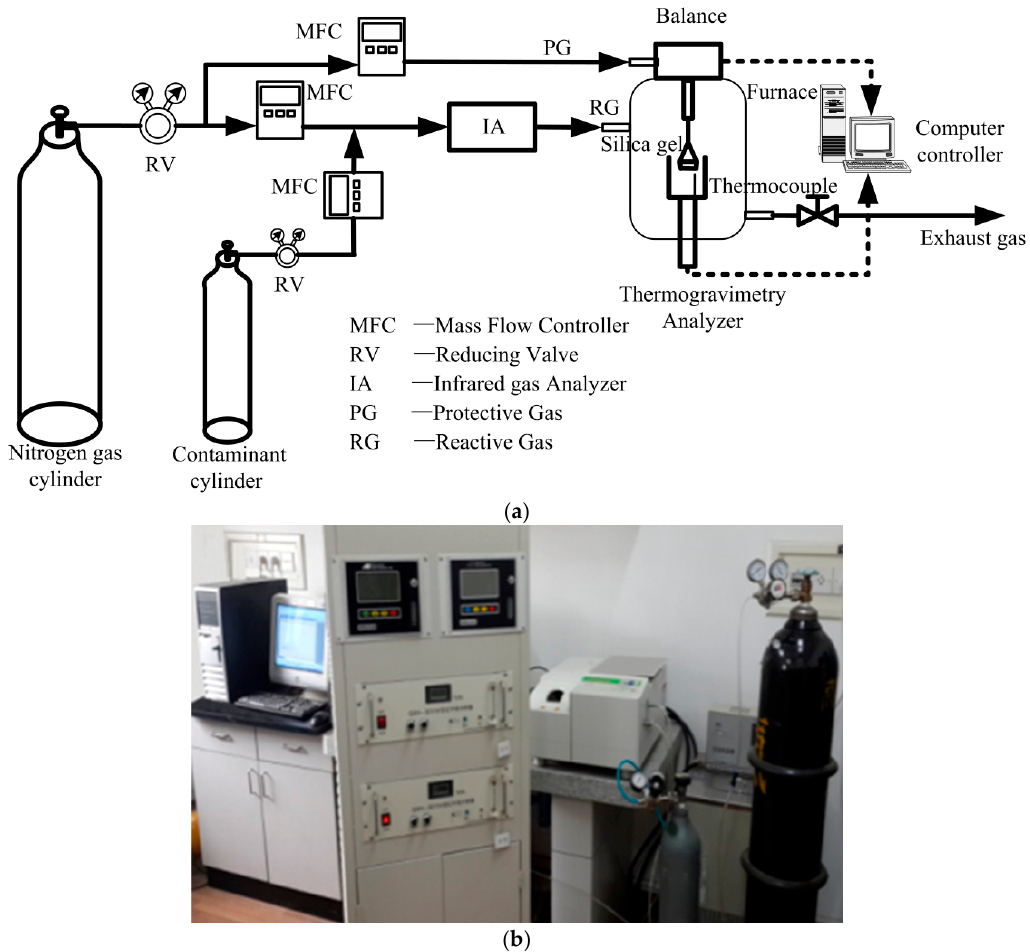
Figure 2. Experimental diagram and experimental apparatus; ( a ) schematic diagram of silica gel thermogravimetric analysis (TGA) experiments; ( b ) experimental apparatus.